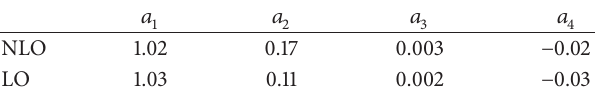
Table 2: Numerical values of effective coefficients 𝑎 𝑖 for 𝑏 → 𝑠 transition at the leading and next to leading order and 𝑁 𝑐 = 3 .